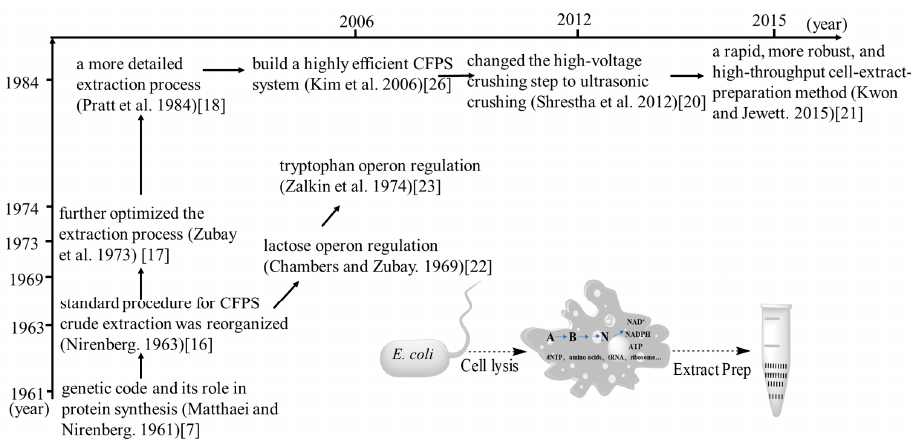
Figure 3. Development of CFSB research in related fields and the main time course of development.